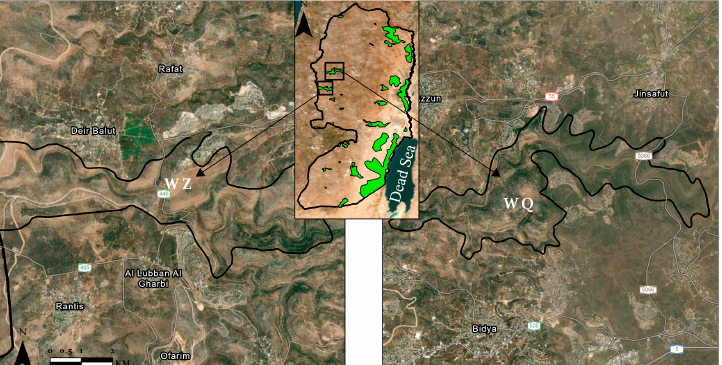
Figure 1. Map of Wadi Al-Zarqa (WZ, left ) and Wadi Qana (WQ, right ) and their position inside the West Bank with other protected areas ( middle , protected areas in green).